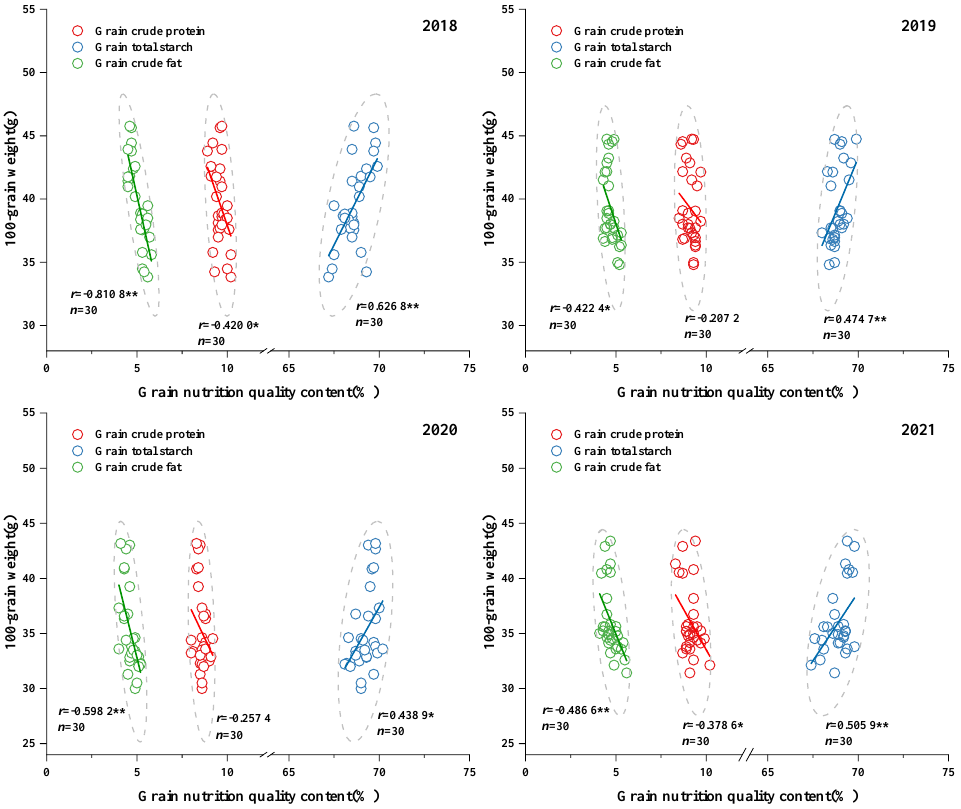
Figure 4. Correlation analysis between grain nutritional quality and the 100-grain weight. Note: “ n ” = the number of samples. “*” significant at p < 0.05, “**” significant at p < 0.01.